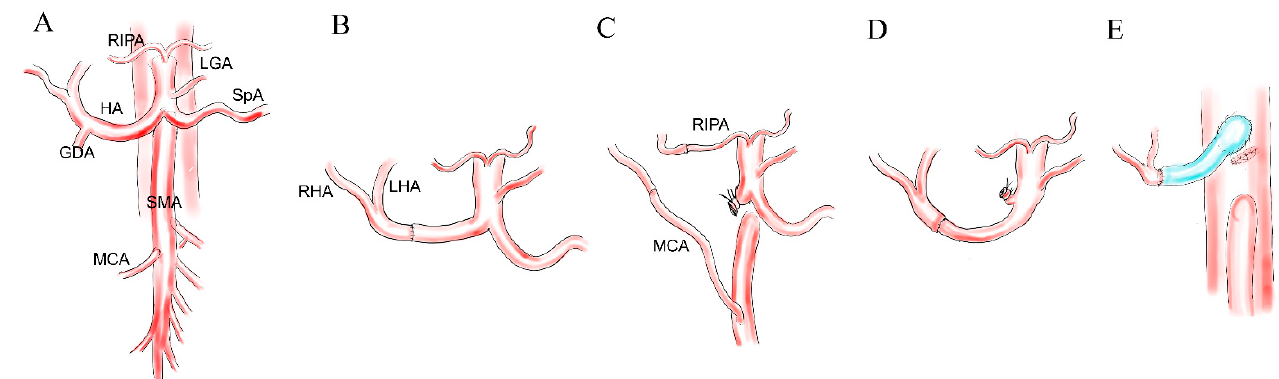
with arterial resection. ‡ Includes patients who had replaced HA. § Each number was not documented.